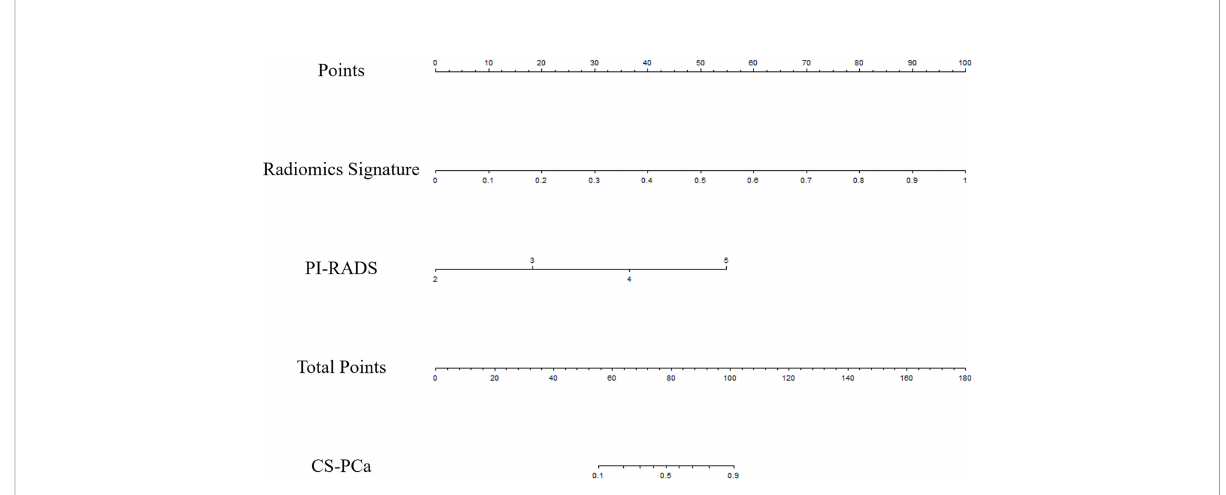
FIGURE 3 The nomogram developed using the training set for predicting CS-PCa, based on the radiomics signature and